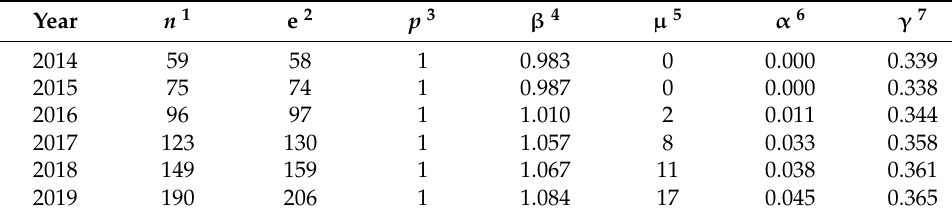
Table 2. Evolution of global topological index of rail transit